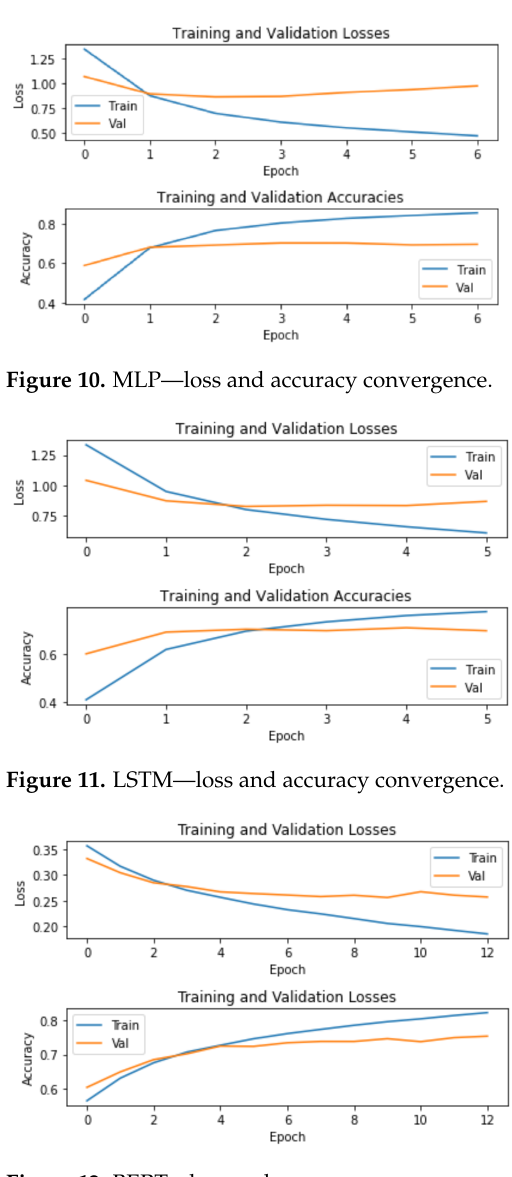
Figure 12. BERT—loss and accuracy